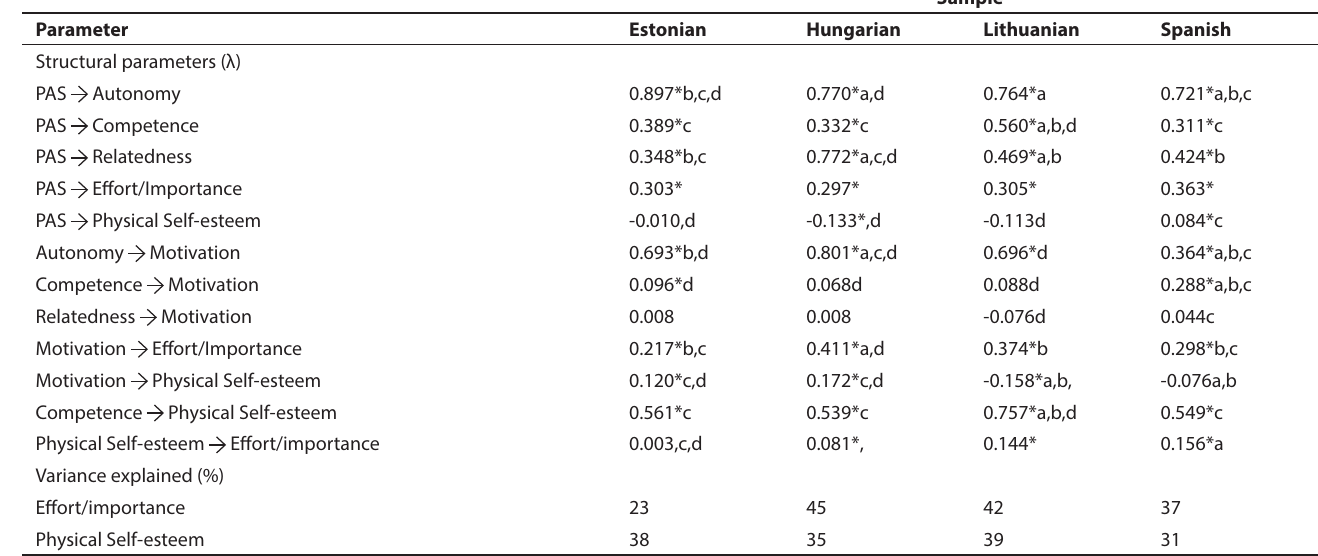
TABLE 3 Standardized Parameter Estimates among Latent Factors and Explained Variance in (%) in Physical Self-esteem and Effort/ importance for the Structural Model for Each National Sample